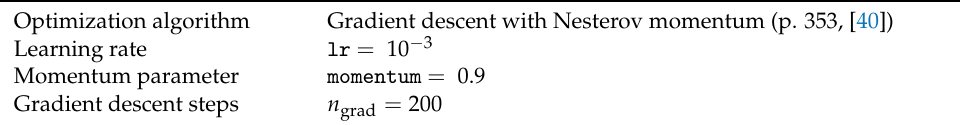
Table 1. Hyperparameter values used for the gradient descent scheme.